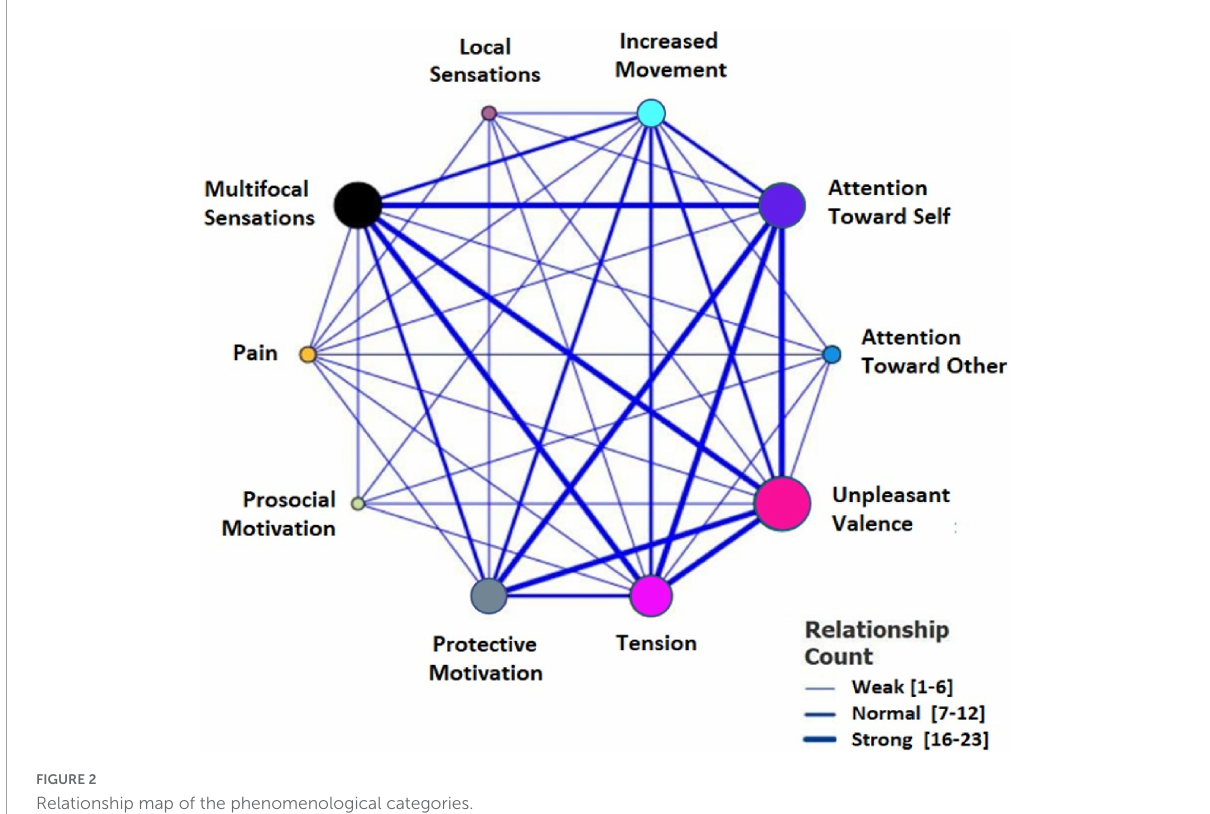
FIGURE2 Relationship map of the phenomenological categories.